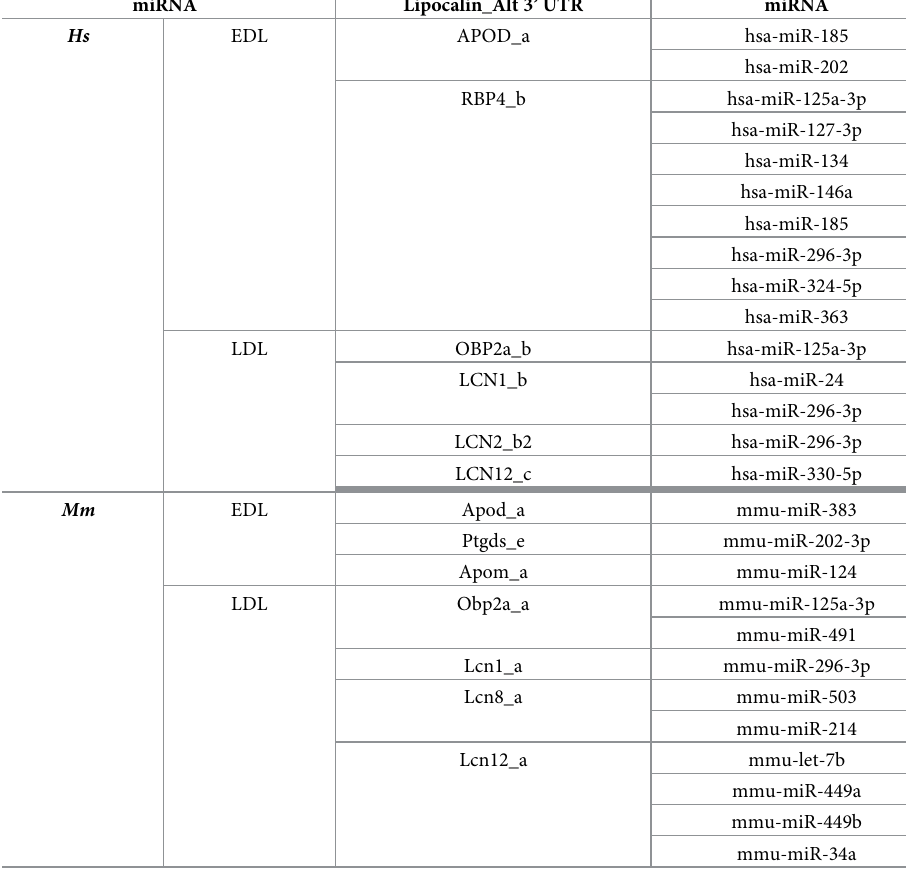
Table 5. Human and mouse predicted miRNAs targets in the 3’ UTR of Lipocalins.